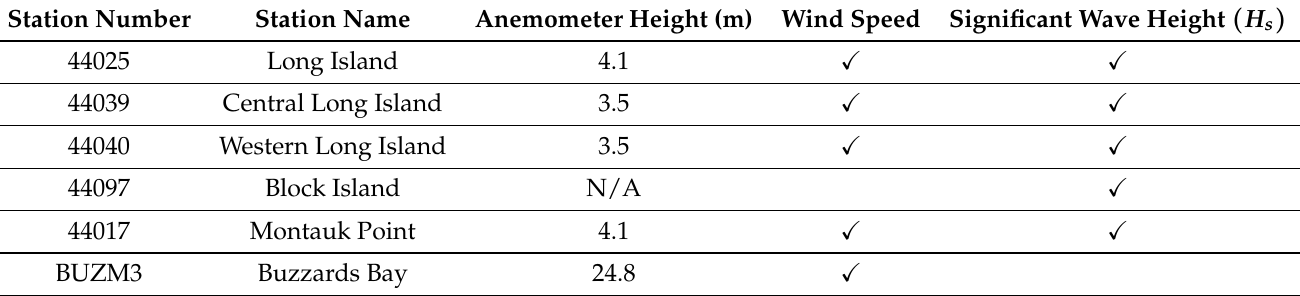
Table 1. In situ observation sites used in this